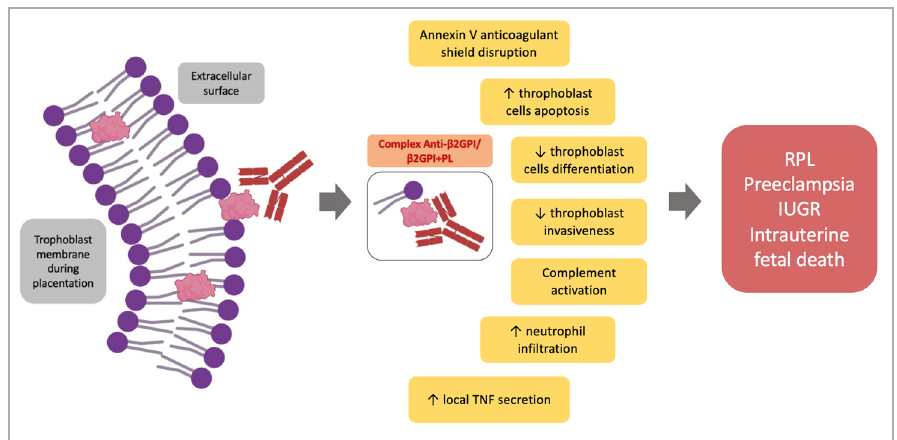
Figure 2. Obstetric APS mechanisms. Here are summarized the main known pathogenetic mechanisms of Anti- β 2GPI and their effects on pregnancy outcomes. PL = phospholipid; TNF = tumor necrosis factor; Anti- β 2GPI = β 2 glicorpotein1-antibodies; β 2GPI = β 2 glycoprotein 1; RPL = recurrent pregnancy loss; IUGR = intrauterine growth restriction.